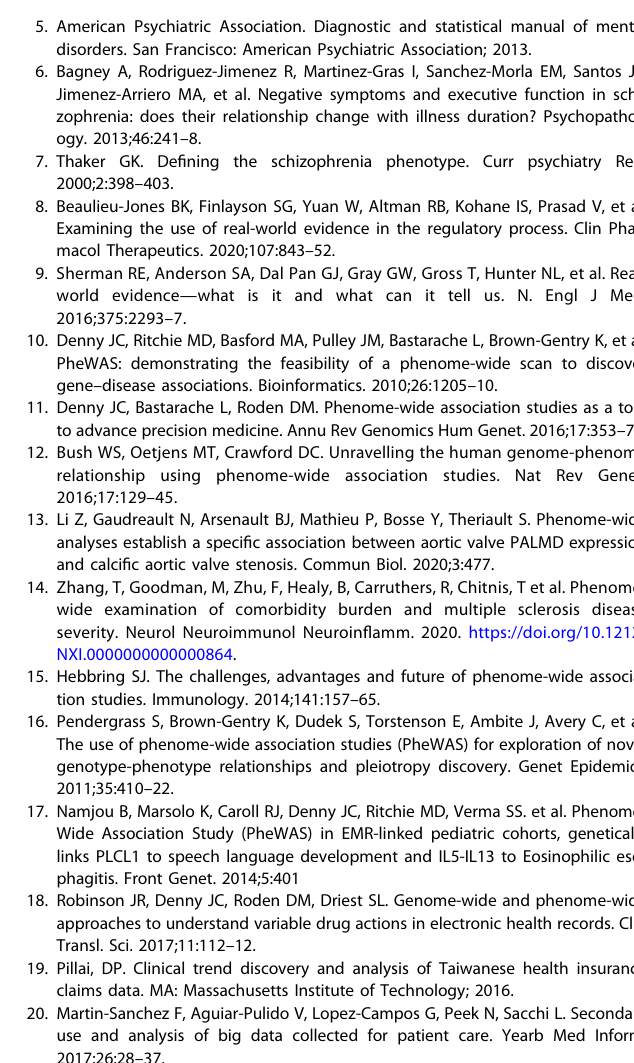
Fig. 3 Phenotypical differences between schizoaffective disorder and other types of schizophrenia. Log 2 (HR) > 0 indicates phenotypes more frequently observed after the diagnoses of schizoaffective disorder, whereas log 2 (HR) < 0 indicates phenotypes more commonly observed after the diagnoses of other types of schizophrenia. The red horizontal dashed line indicates the Bonferroni-corrected P -value threshold. The gray vertical dashed lines indicate the HR of 2 and 0.5,